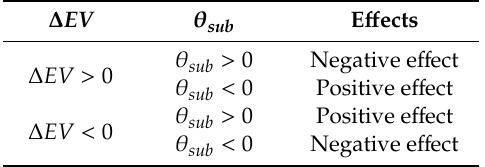
Table 1. Classifications of e ff ects from decoupling